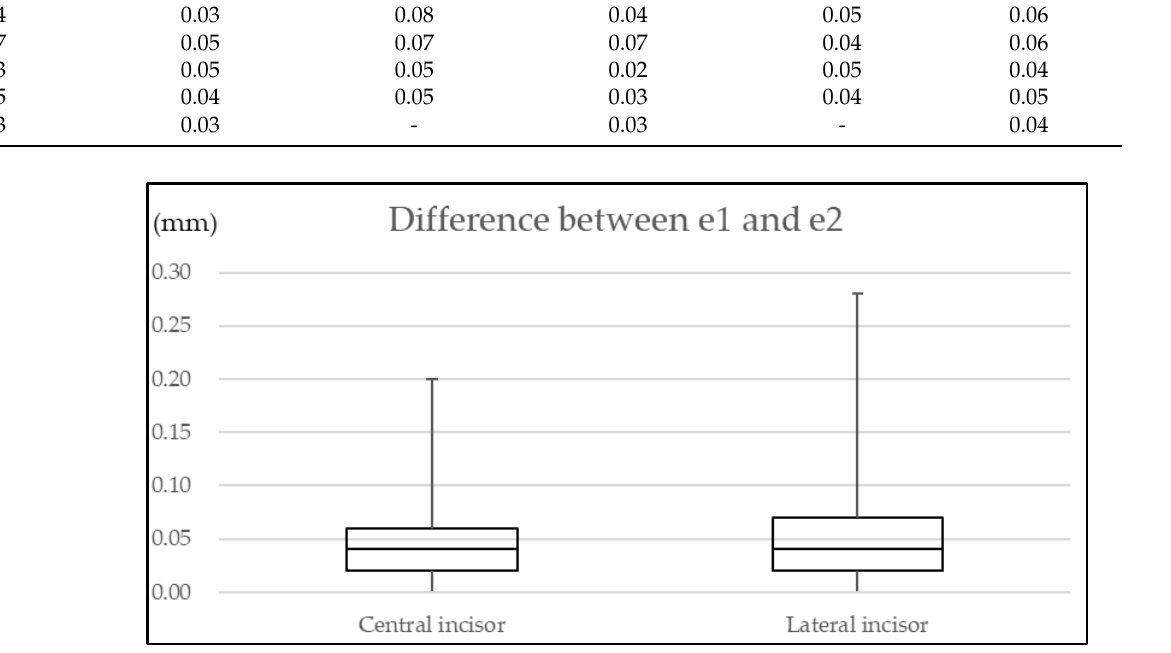
Figure 1. Difference between e1 (measured by OCT) and e2 (measured by microscopy).